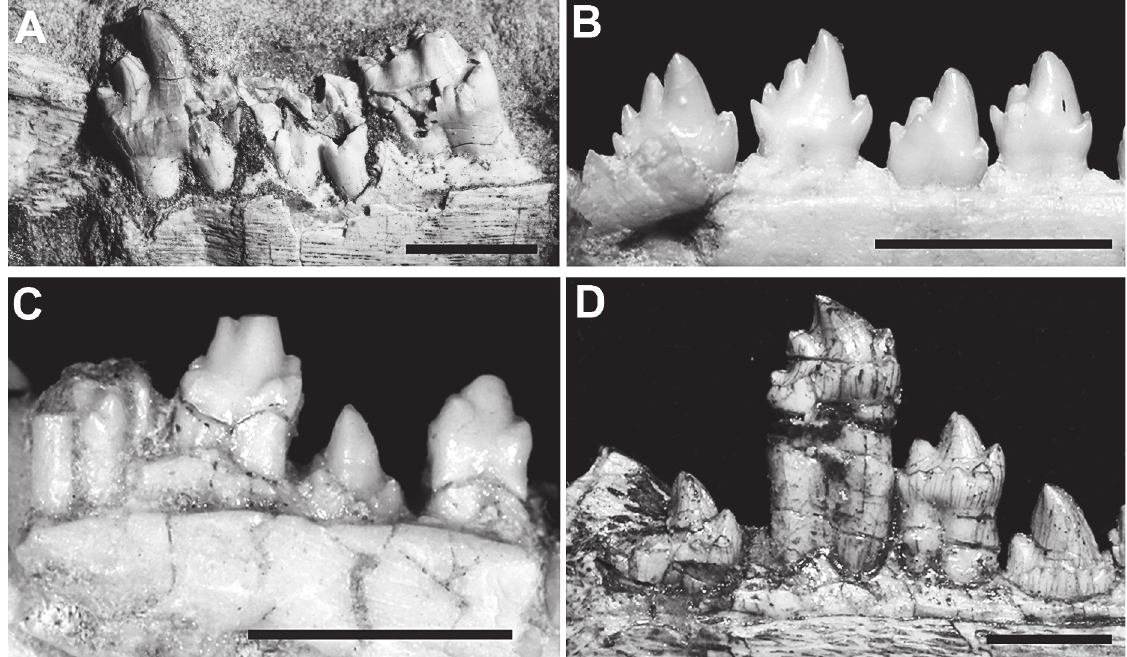
Fig. 6 - Comparisons of the right posterior lower postcanines in lingual view. A: Botucaraitherium belarminoi gen. nov. et sp. nov (Holotype MMACR-PV-003-T). B: Brasilitherium riograndensis (UFRGS-PV-0603-T); C: Brasilodon quadrangularis (UFRGS-PV-0765-T). D: Prozostrodon brasiliensis (Holotype UFRGS-PV-0248-T). Scale bar equals 3